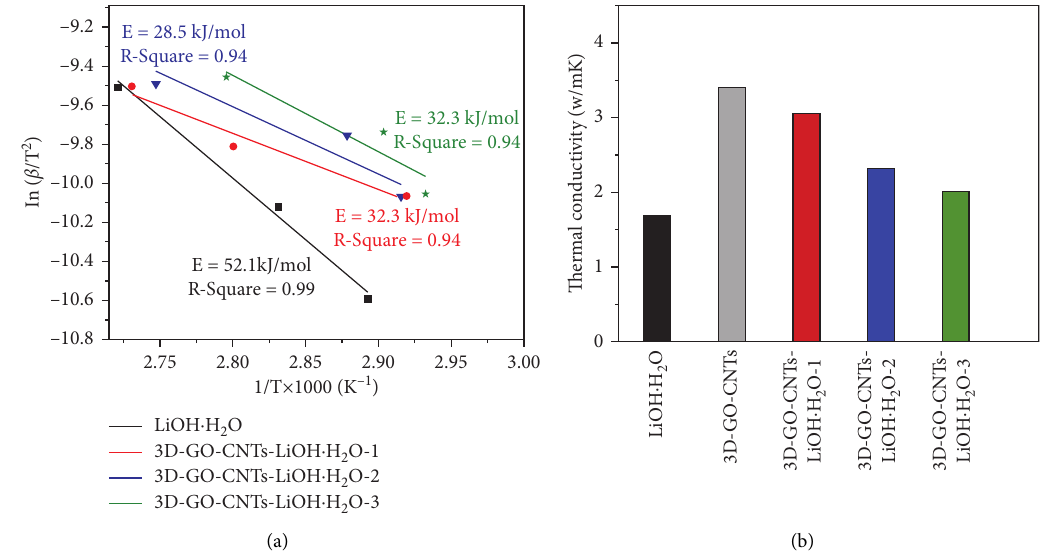
Figure 8: (a) Activation energy of dehydration reaction of LiOH · H and 3D-GO-CNTs-LiOH · H 2 O-3; (b) thermal conductivity of LiOH · H 2 O, 3D-GO-CNTs, 3D-GO-CNTs-LiOH · H 2 O-1, 3D-GO-CNTs-LiOH · H 2 O- 2, and 3D-GO-CNTs-LiOH · H 2